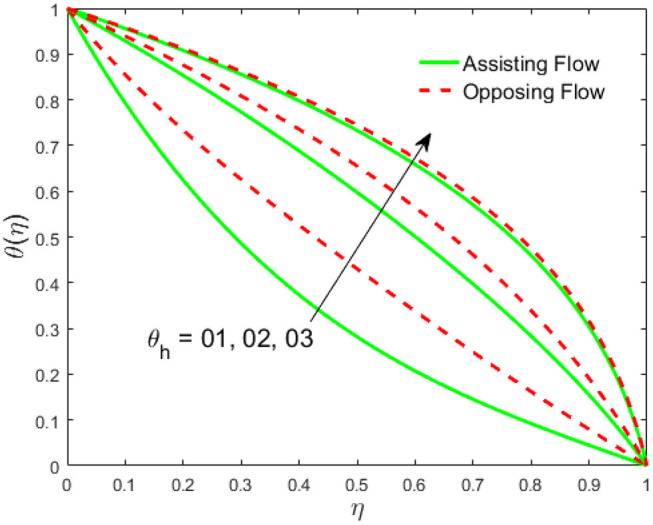
Impact of Rd on θ(η).